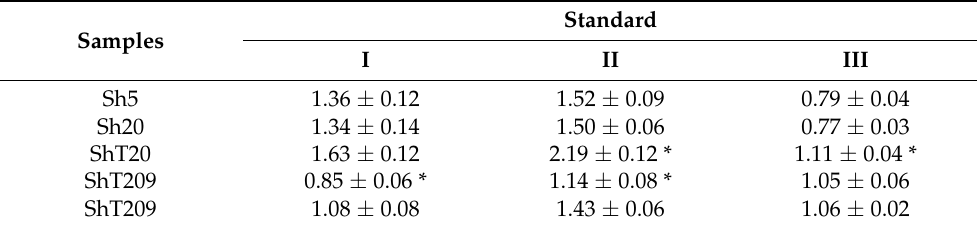
Table 2. Antioxidant activity (mg/g according to the standard) of shungite extracts (DPPH method). Samples